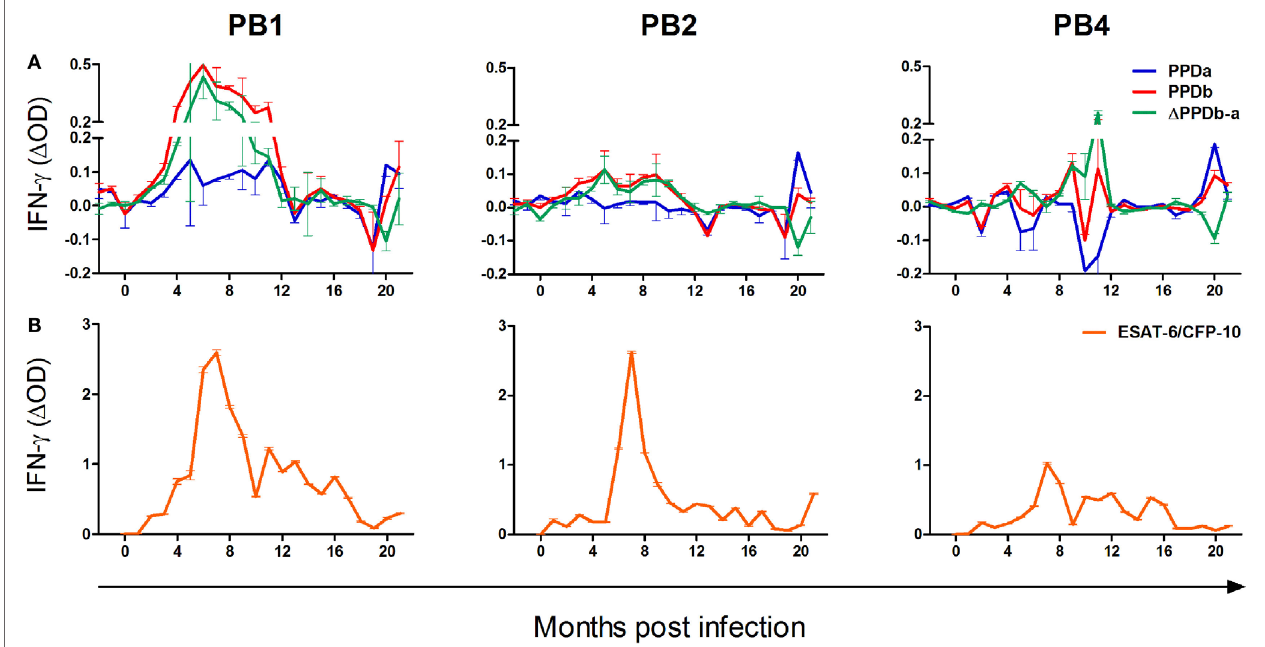
FigUre 1 | The kinetics of the cell-mediated immune response to Mycobacterium bovis infection in the white rhinoceros. Following M. bovis infection, whole blood from three animals (PB1, PB2, and PB4) was incubated overnight at 37°C without stimulation, or stimulation with bovine PPD purified protein derivative (PPDb), avian PPD (PPDa), and 6 kDa early secretory antigenic target (ESAT-6)/10 kDa culture filtrate protein (CFP-10)/TB7.7 peptides, respectively. Plasma interferon-gamma (IFN- γ ) was measured by enzyme-linked immunoassay, in duplicate, as the optical density (OD), and antigen-specific release calculated as the OD derived for the unstimulated sample subtracted from that derived for each antigen (mean Δ OD ± SD). (a) Antigen-specific IFN- γ release in response to PPDb and PPDa, and the differential response to these antigens ( Δ PPDb-a); (B) Antigen-specific IFN- γ release in response to ESAT-6/CFP-10/TB7.7